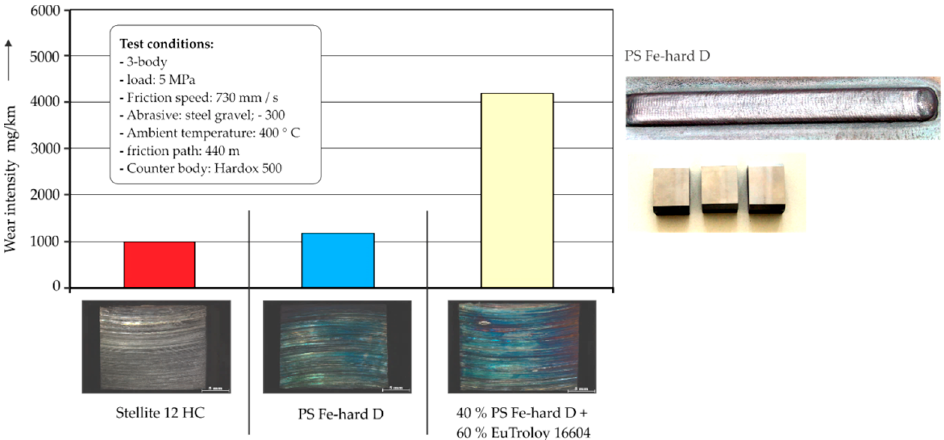
Figure 5. Results of the 3-body abrasive sliding wear test on the PMD layers.